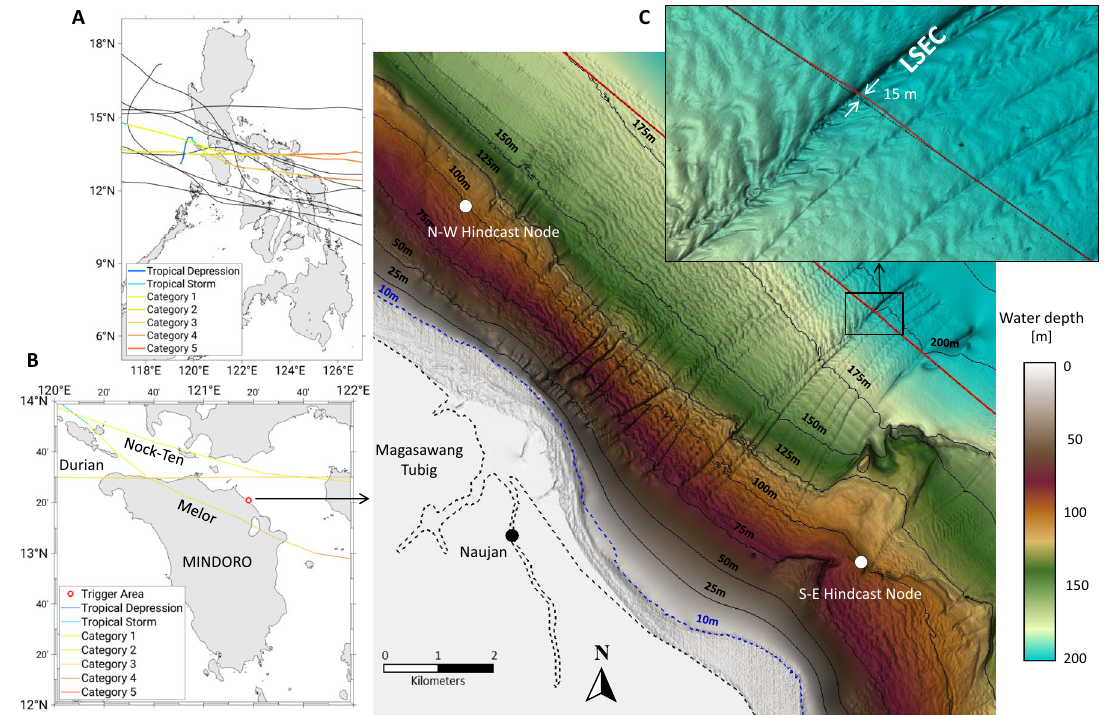
Fig. 1 Bathymetry map of the MT submarine canyon system. Insets indicate a tracks of typhoons passing near Mindoro Island after the pipeline installation highlighting the most relevant typhoons with colours that represent the 1 – 5 rating based on the Saf fi r – Simpson Scale (IBTrACS, http://www. ncdc.noaa.gov/oa/ibtracs), b location of the trigger area and c details of the detected pipeline displacement. Black dashed line is the pipeline as built. Red continuous line is the pipeline